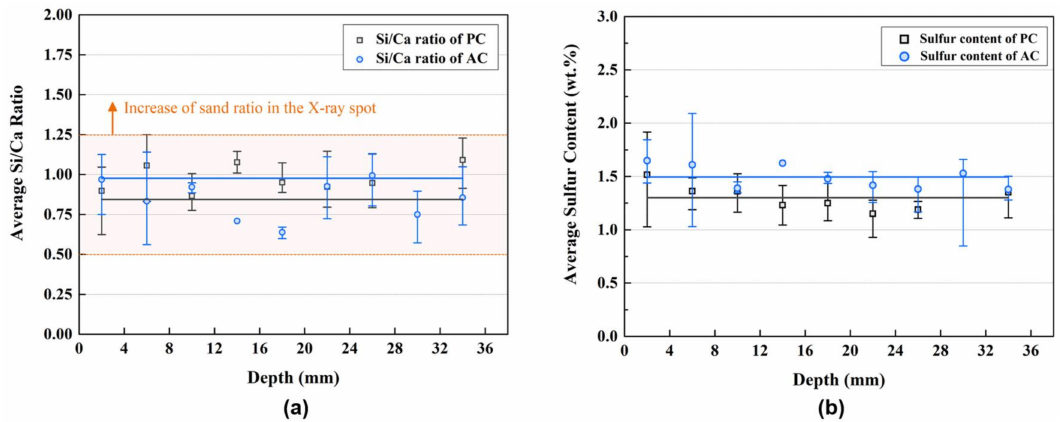
Figure 8. Chemical content of the mortar section: ( a ) Si/Ca ratio of the mortar; and ( b ) sulfur content of the